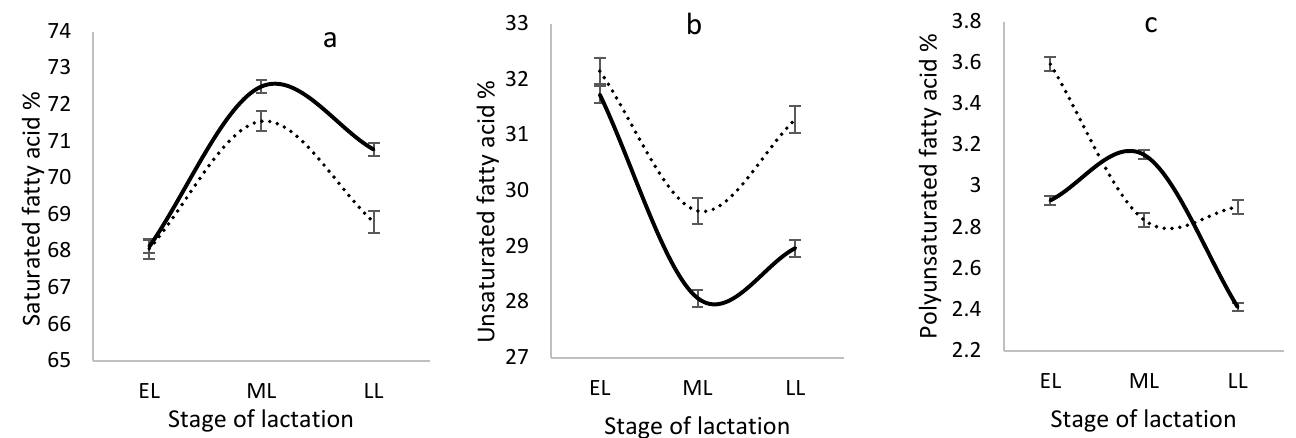
of lactation were <0.0001 for saturated, unsaturated, and polyunsaturated fatty acids.